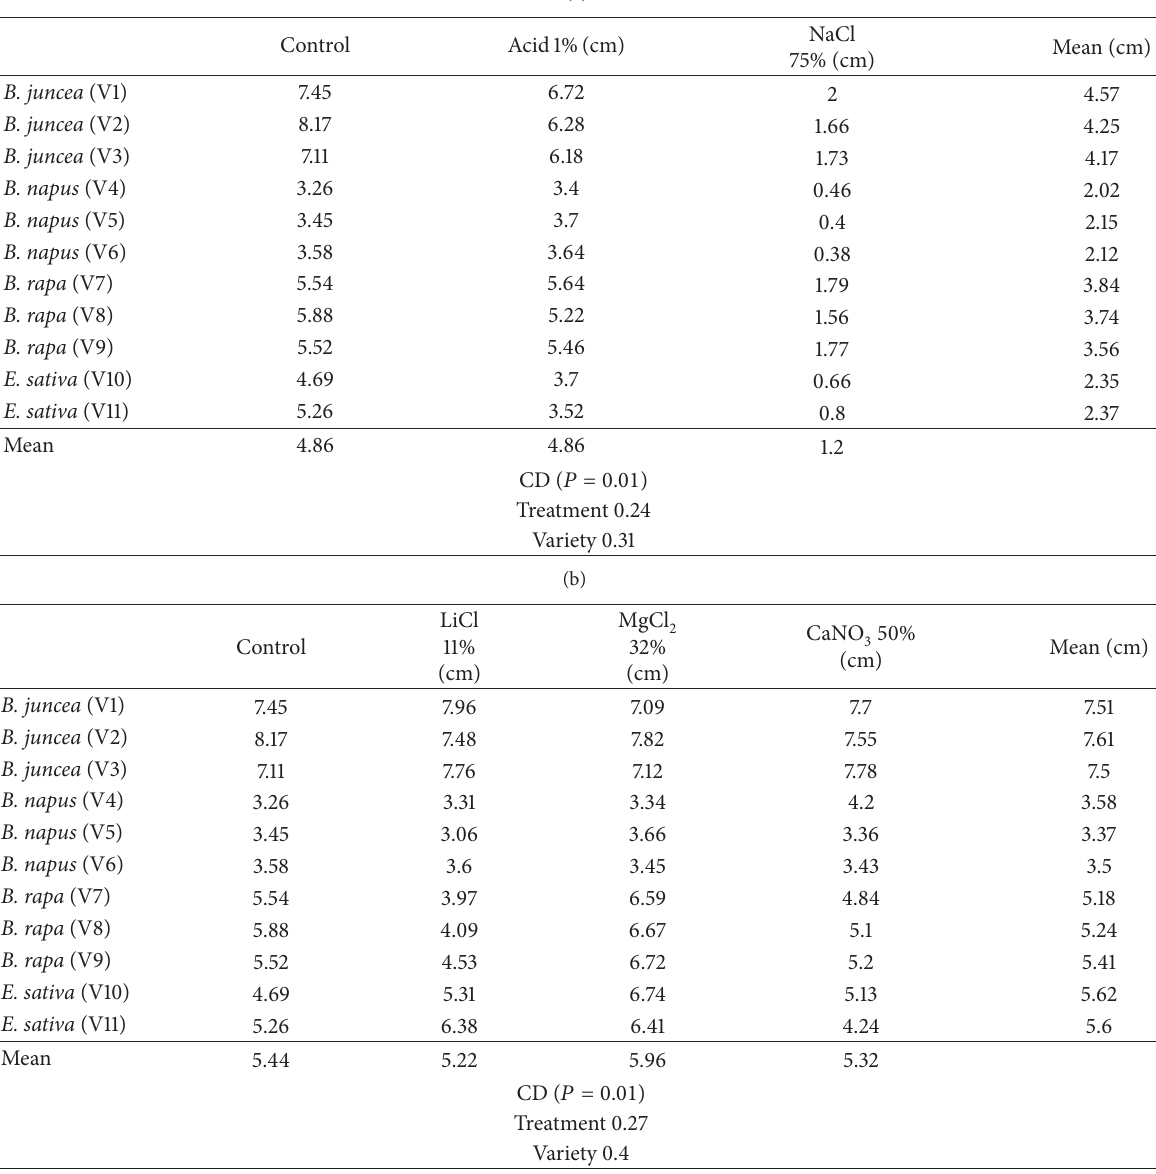
Table 4: Effect of high and low (a) and intermediate (b) RH on root length of various accessions of Brassica spp. and Erucasativa .